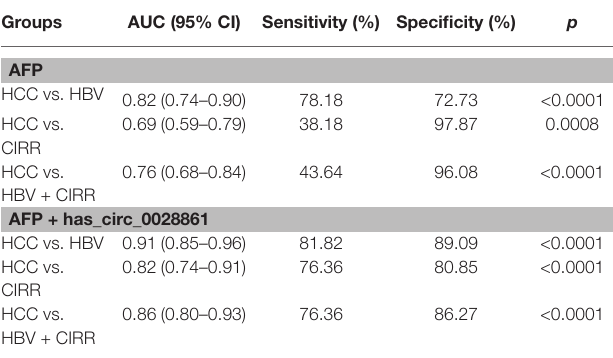
TABLE 5 | The combination of has_circ_0028861 and AFP for HCC detection.